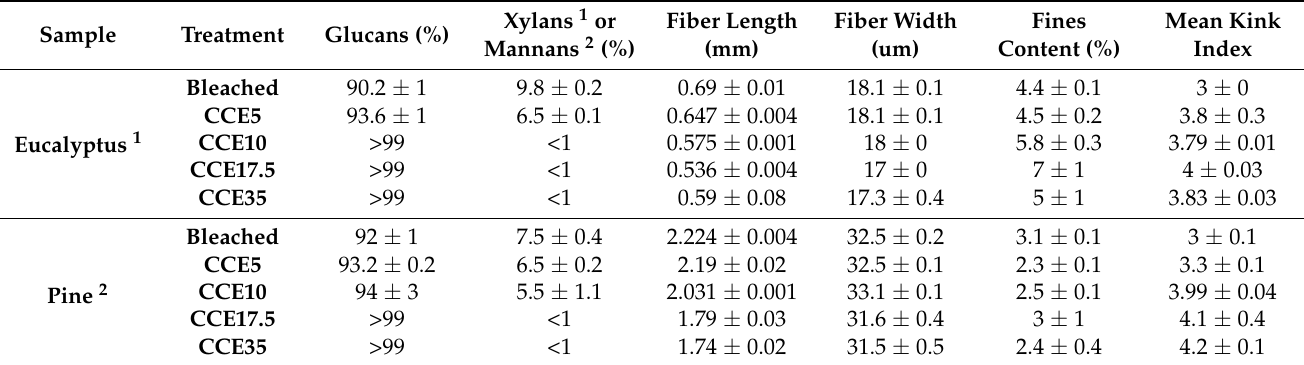
Table 1. Chemical composition and fiber biometry of eucalyptus and pine pulps. Mean ± standard deviation of each variable is